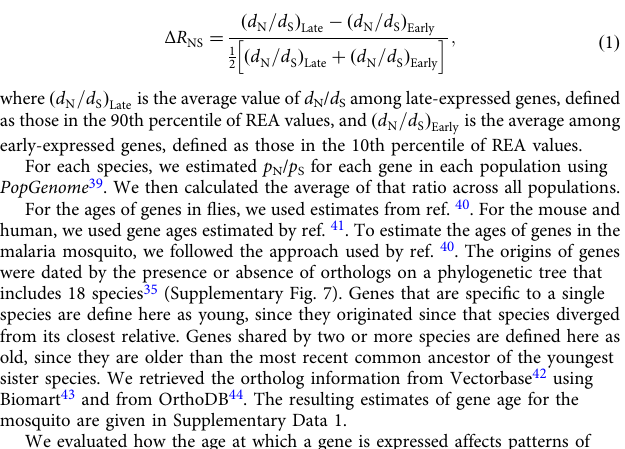
ffiffiffiffiffiffiffiffiffiffiffiffiffiffiffiffiffiffiffiffiffiffiffiffiffiffiffi p 1 2 k 1 (cid:2) 4 α ð 1 (cid:2) α Þ